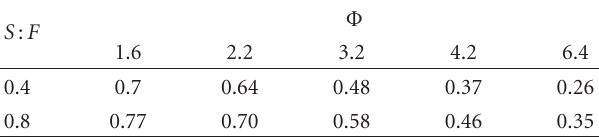
Table 4: Energy conversion e ffi ciency (ECE) as a function of the Φ and various S : F ratios, adapted from